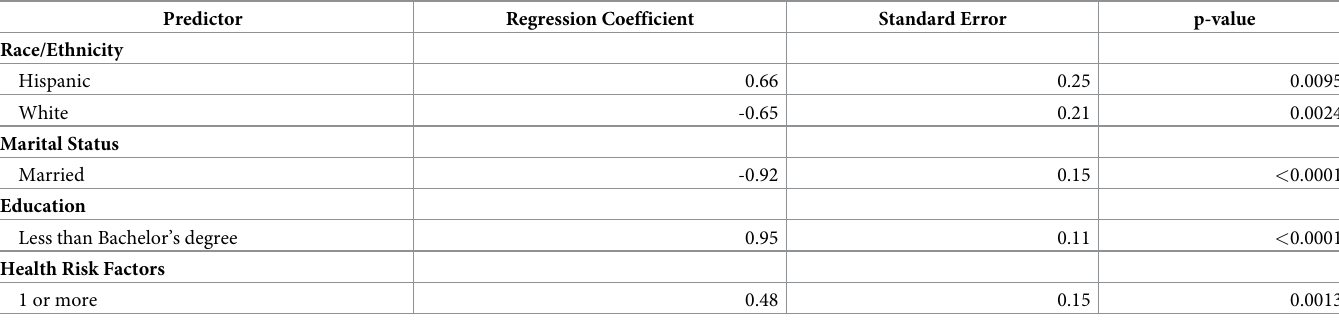
Table 5. Predictors of financial vulnerability–demographic, health, and employment factors (multivariate linear